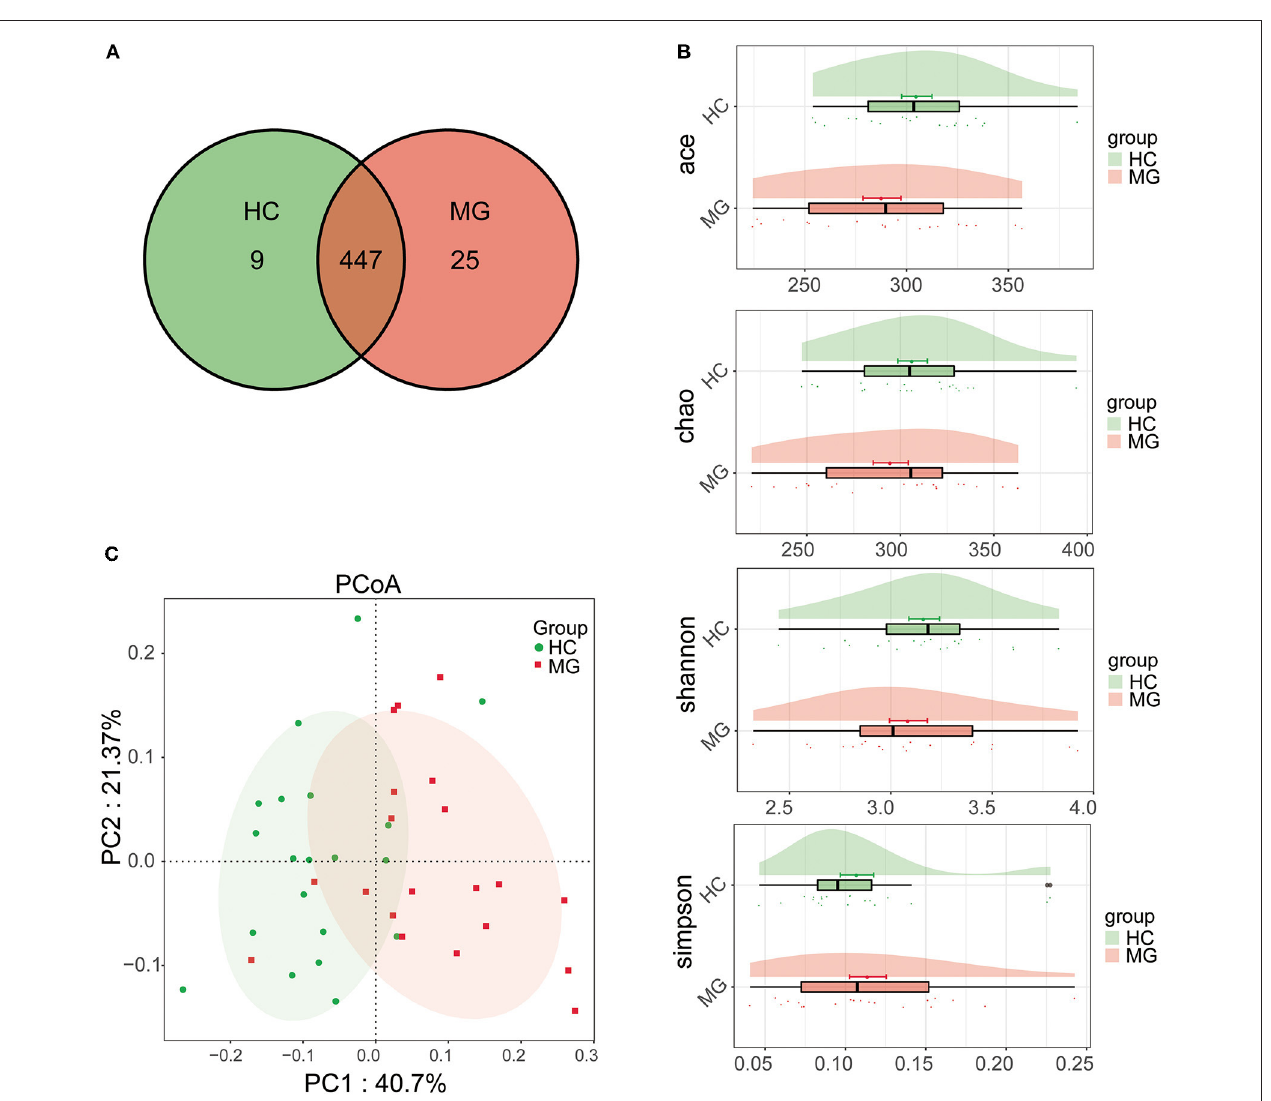
FIGURE 1 | Comparison of microbial diversity between MG (N = 20) and HC ( N = 20) groups. (A) Venn diagram of OTU distributions (B) Alpha diversity estimated by the ACE, Chao, Shannon, and Simpson indices (C) Beta diversity analyzed by PCoA based on a weightedUniFrac algorithm.